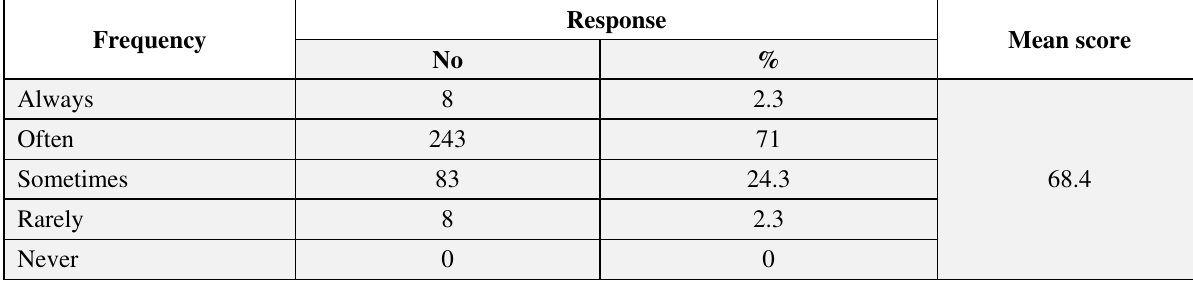
Figure 1. Theoretical proposition 1: PPP cost efficiency